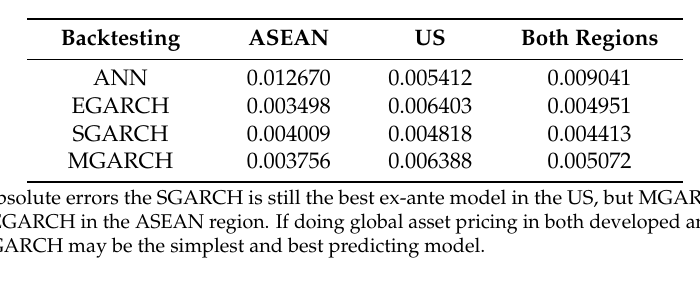
Table A4. Forecast Mean Absolute